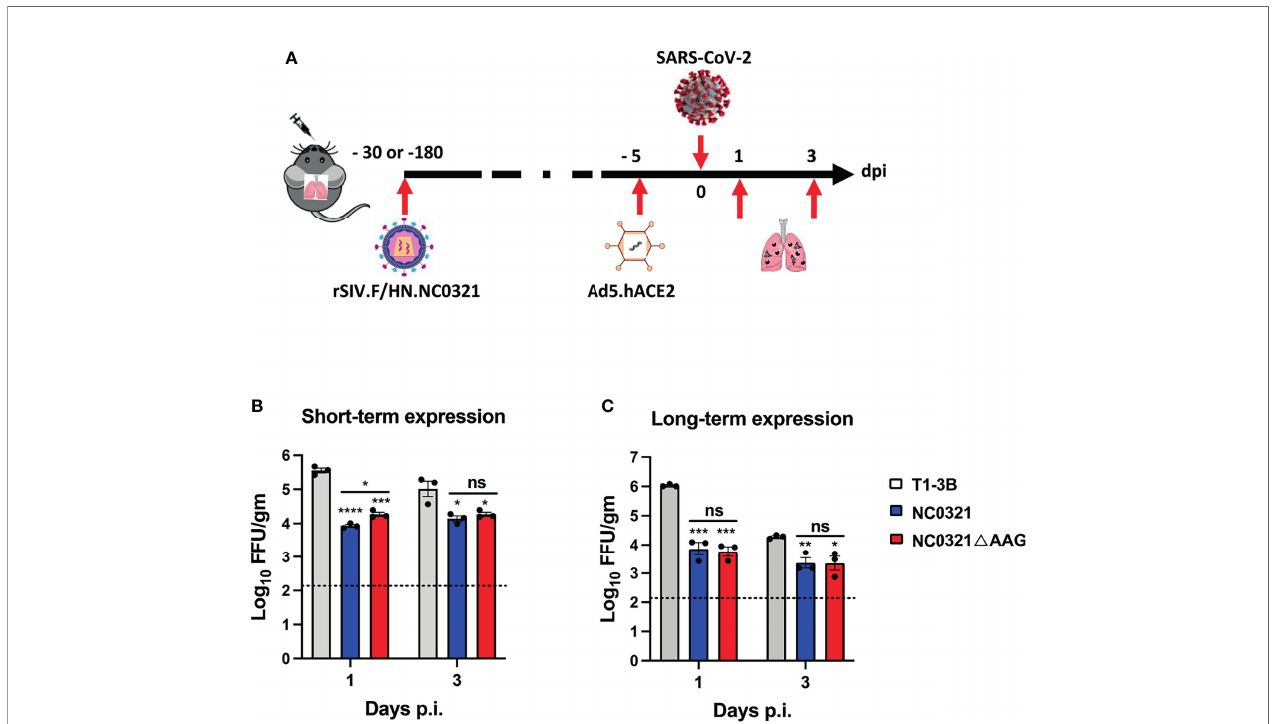
FIGURE 4 | Protection against SARS-CoV-2 infection with vector-mediated NC0321 gene transfer. Viral load was measured in the lungs of groups (n = 3) of BALB/ c mice 1 and 3 dpi with the 1E5 FFU SARS-CoV-2 strain (SARS-CoV-2/human/CHN/IQTC01/2020, GenBank: MT123290.1). Groups had previously received 1E8 TU rSIV.F/HN-NC0321, rSIV.F/HN-NC0321DAAG, or rSIV.F/HN expressing an isotype control (A) , as indicated, 30 (B) or 180 days (C) previously. All animals received Ad5-hACE2 5 days prior to SARS- CoV-2 infection. Lungs were harvested for viral titers at 1 and 3 dpi (n = 3 mice per group). Dotted line indicates limit of detection (LOD); gm indicates gram lung tissue. ns, **, *** and **** represent p > 0.05, p < 0.05, < 0.001 and < 0.0001,